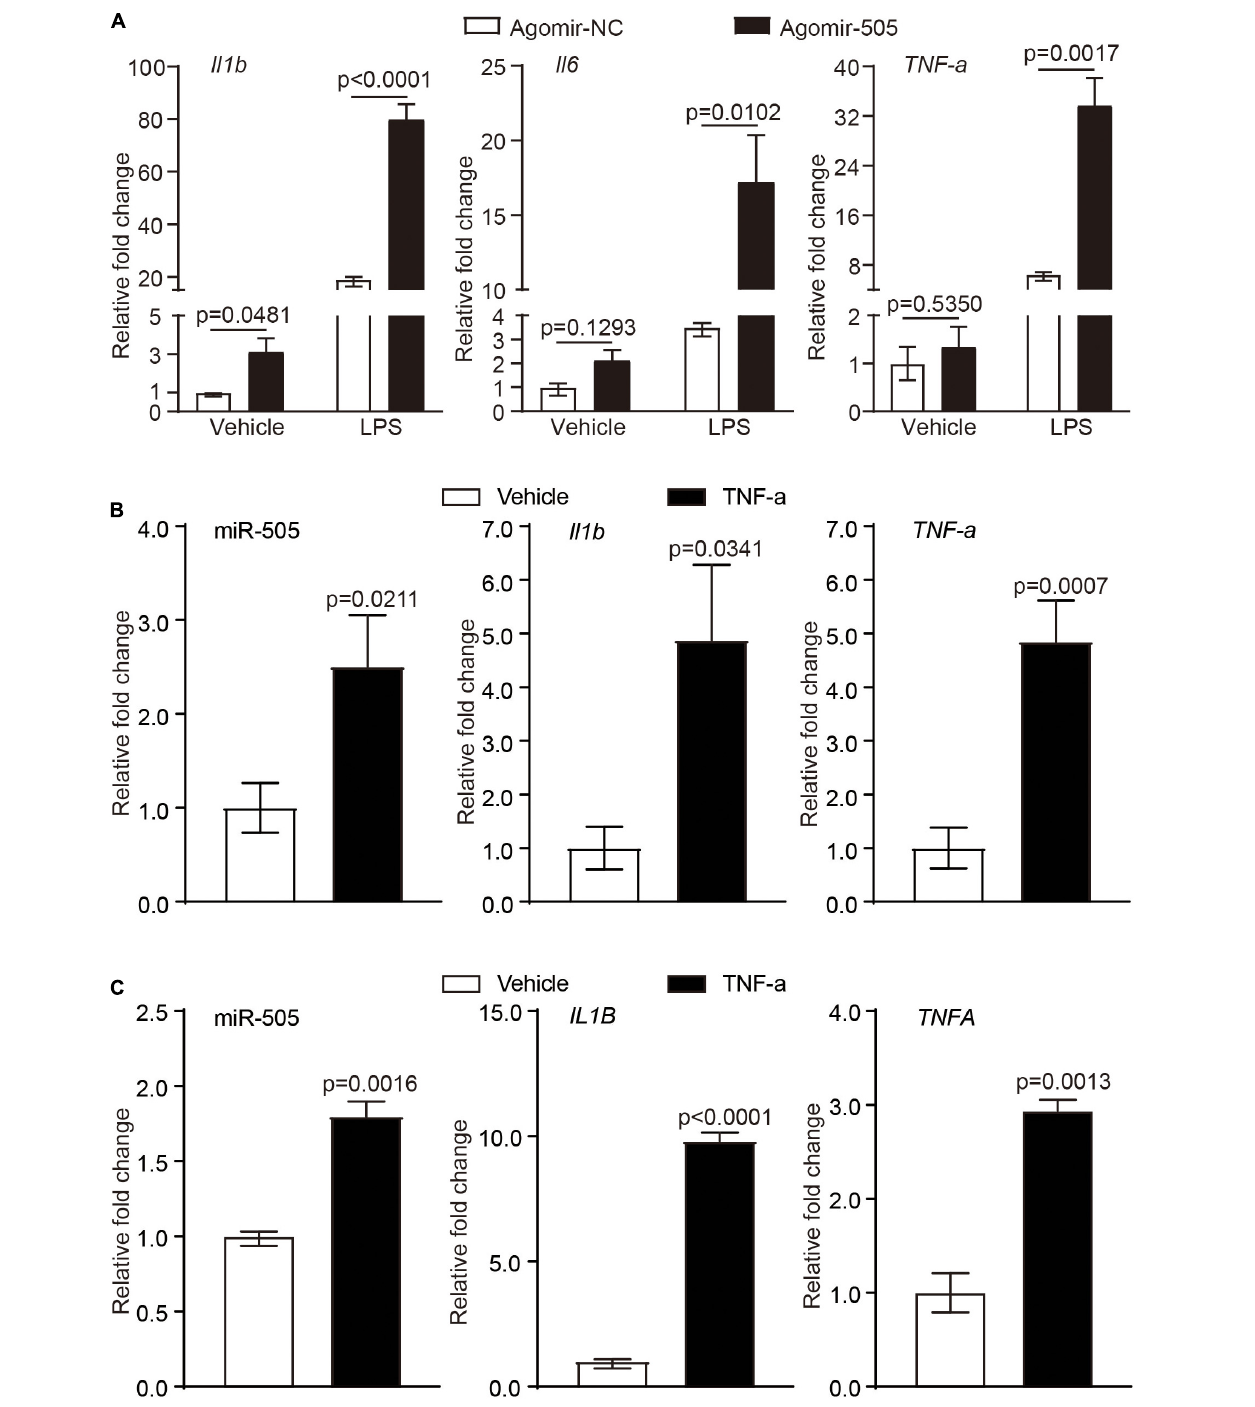
FIGURE 4 | MiR-505 increases the sensitivity of immune cells to the proinflammatory stimuli. (A) Agomir-505 (10 mg/kg bw) or agomir-NC (10 mg/kg bw) was intravenously administered for 2 weeks. PMBCs isolated from agomir-505-treated ( n = 5) and agomir-NC-treated mice ( n = 3) were subject to vehicle or 5 ng/mL LPS stimulation for 6 h. The expression of Il1b , Il6 and TNF- α was then analyzed by real-time qPCR analysis. Relative fold change was plotted against that from agomir-NC and vehicle-treated PBMCs. Data represent mean ± SEM. P values are derived from one-way ANOVA and the Student’s t -test. (B) PBMCs isolated from C57/BL6 mice were treated by vehicle or 10 ng/mL TNF- α for 24 h, followed by real-time qPCR analysis of the expression of miR-505, Il1b and TNF- α . Relative fold change was plotted against that from vehicle-treated PBMCs ( n = 4 per group). Data represent mean ± SEM. P values are derived from the Student’s t -test. (C) THP-1 cells were treated by vehicle or 10 ng/mL TNF- α for 24 h, followed by real-time qPCR analysis of the expression of miR-505, IL1B and TNFA. Relative fold change was plotted against that from vehicle-treated THP-1 cells ( n = 4 per group). Data represent mean ± SEM. P values are derived from the Student’s t -test.